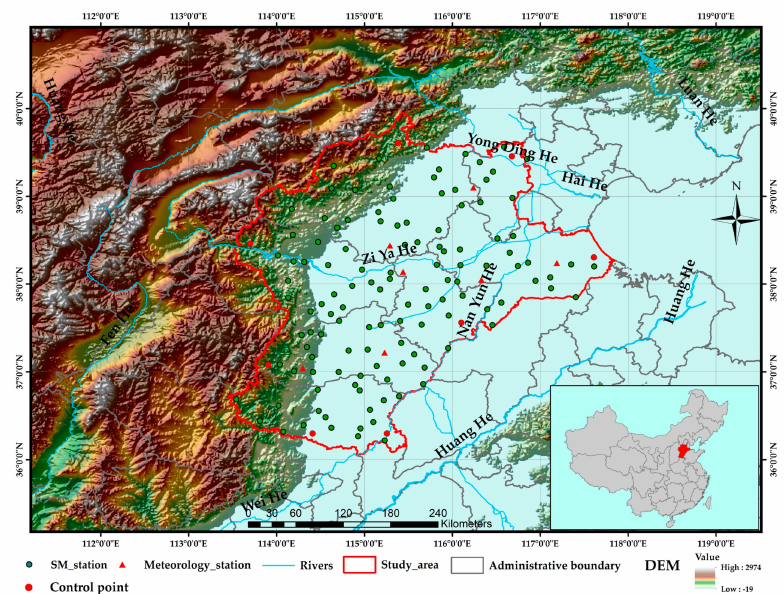
Figure 1. Study area and meteorological sites locations and the spatial distribution of SM stations.